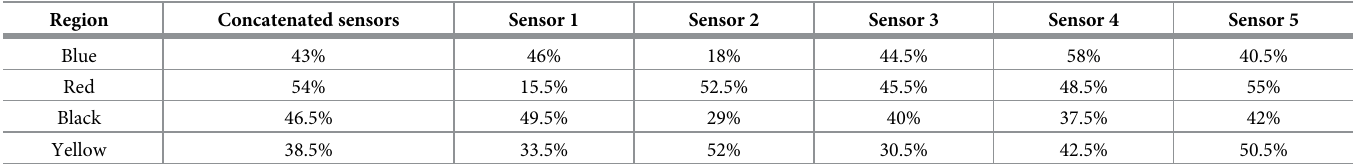
The performances obtained by the 10-fold cross-validations are presented. The percentages indicate the number of correctly classified positions divided by the true number of total positions in each